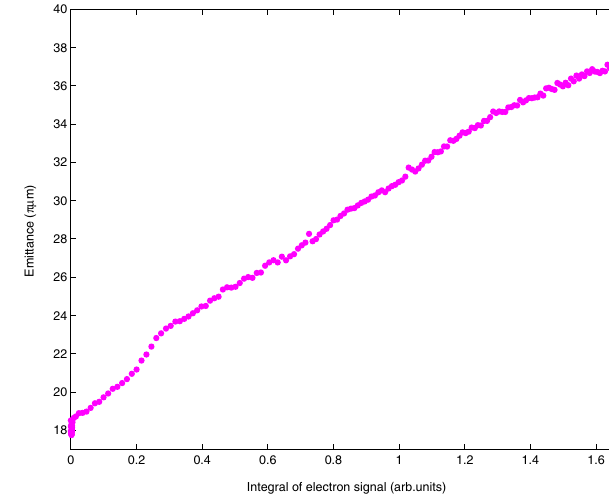
FIG. 10. (Color) Blue bunch train, on the bottom, the electron multipacting signal of the Blue vertical detector at section 1, in the middle, and the bunch length and bunch intensity reduction ratio along the bunch train, in 20 minutes after the injection is completed.